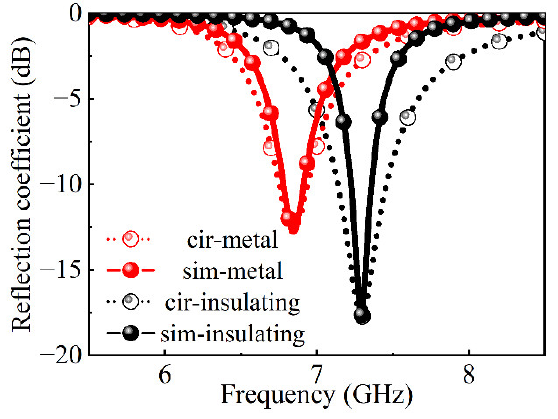
Figure 3. The circuit simulation and the full-wave simulation.